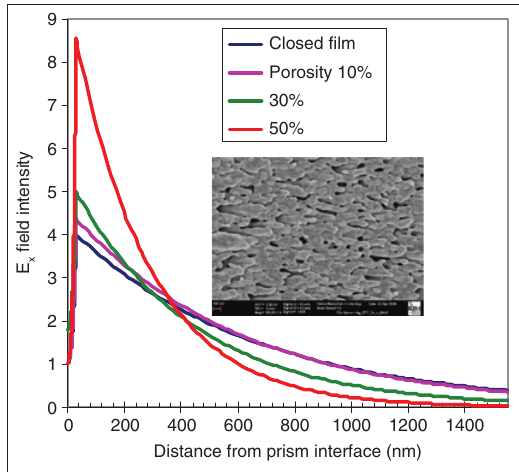
Figure 6: Simulated field distribution for thin metal on prism configuration with different porosities of the columnar silver film. Wavelength used is 1550 nm. Reproduced with permission from